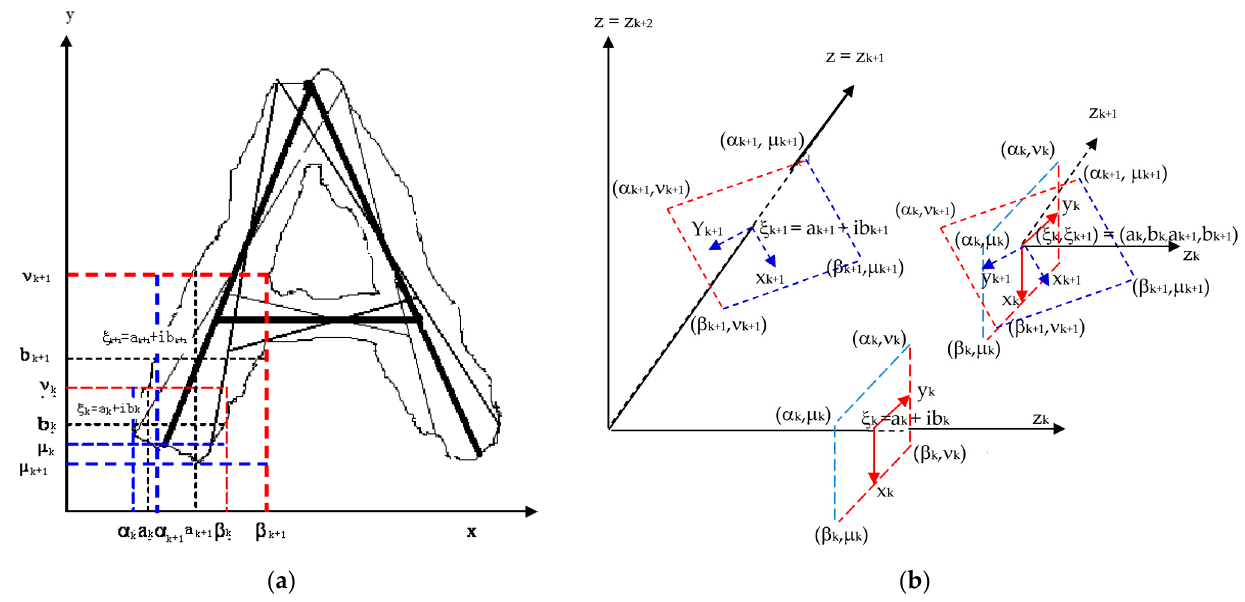
Figure 6. Qualitative transformation functor conversion from two dimension pattern “A” into Hil- bert space. ( a ) Envelopes E(A) of several handwritten A, the intersections of sampling points x = a k and x = a k+1 , y = b k and y = b k+1 and a certain A ξ k = a k + ib k ， ξ k+1 = a k+1 + ib k+1 , and the intersection of x = a k and y = b k with E(A) [ μ k , ν k ] and [ α k , β k ]; ( b ) A Qualitative Criterion [ α , β ] for Recognizing Pattern A in 2D, and the Neighborhood ( ξ k , ξ k+1 ) = (a k ,b k ,a k+1, b k+1 ) of Tensor {[ α k , β k ] × [ μ k , ν k ]} ⊗ {[ α k+1 , β k+1 ] × [ μ k+1 , ν k+1 ]}.